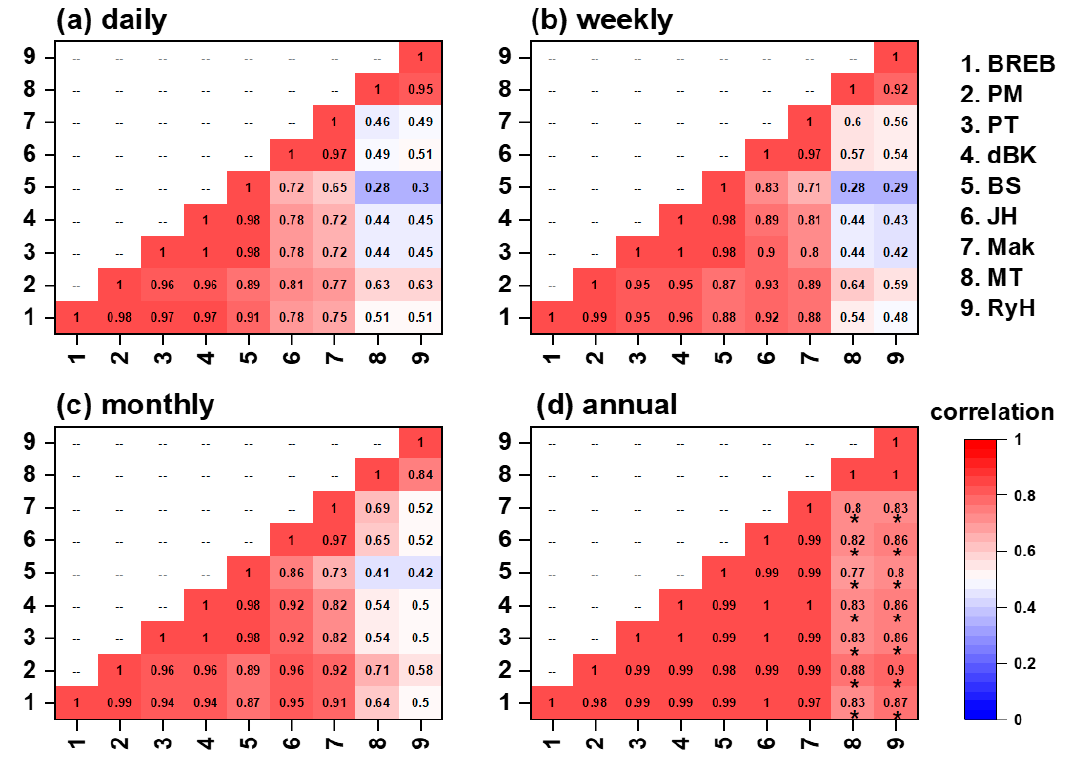
Figure 7. Correlations between default evaporation methods at ( a ) daily, ( b ) weekly, ( c ) monthly, and ( d ) annual timescale during 2015–2018. The asterisk * means the correlation is not significant at the 0.05 confidence level by the Student’s t